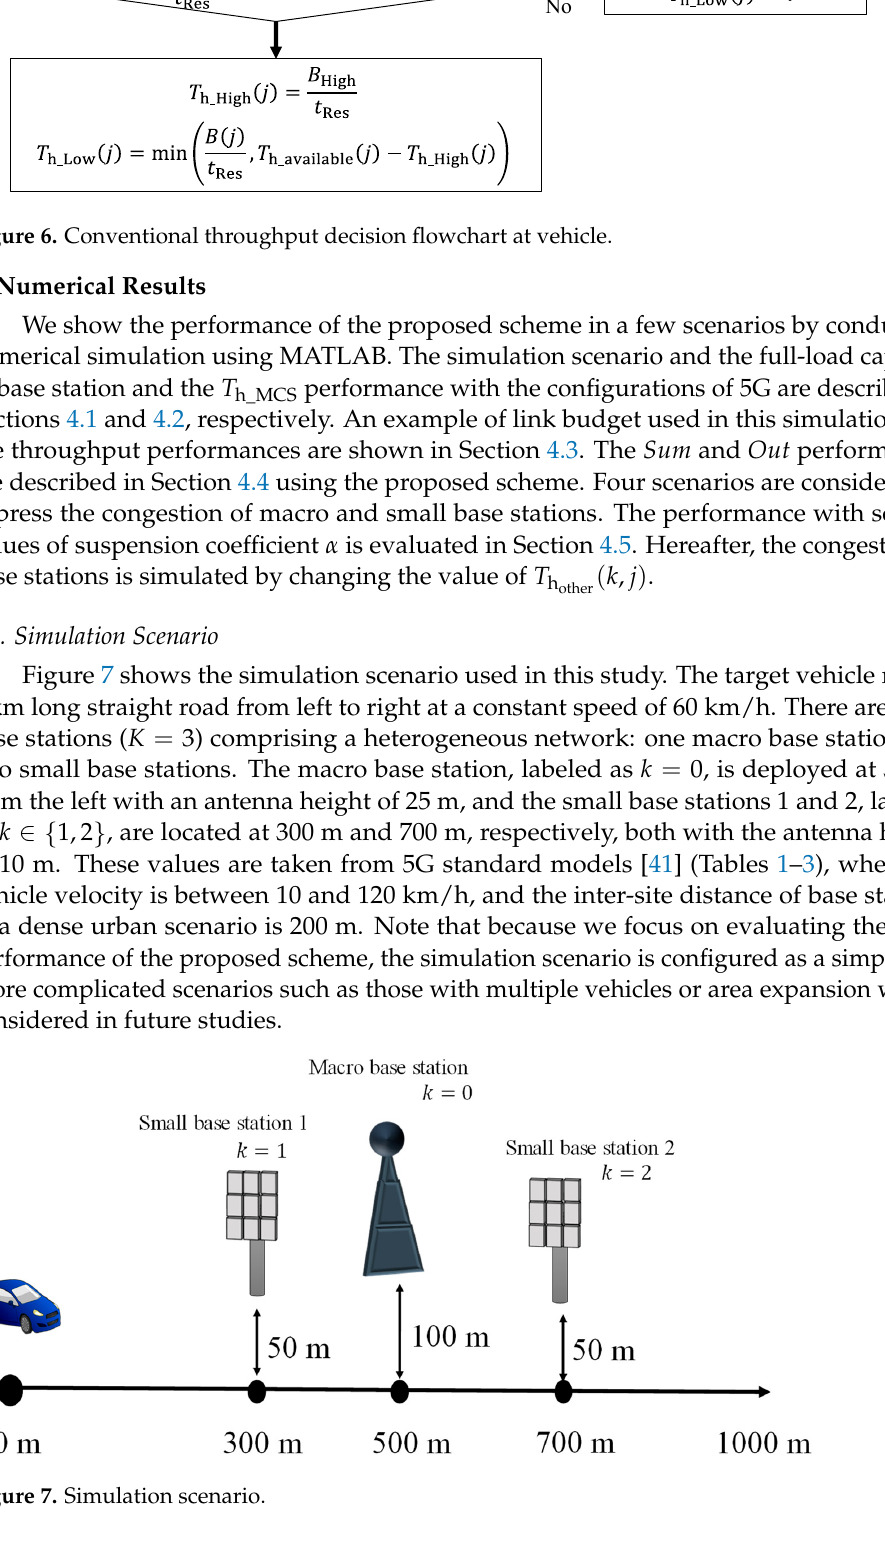
Figure 5. Proposed throughput decision flowchart at vehicle.